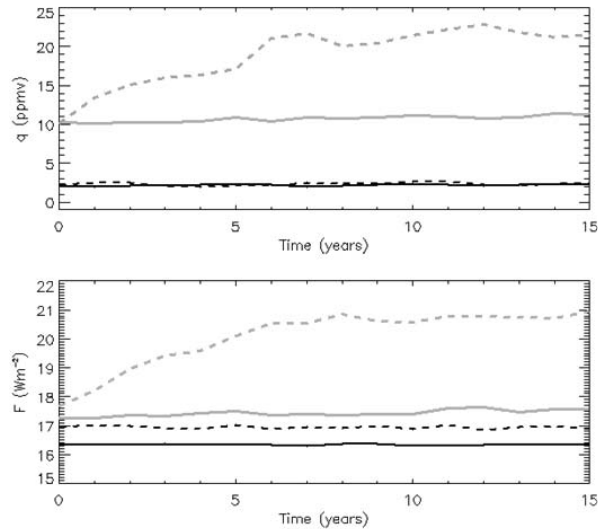
Fig. 6. Top panel: the evolution of globally averaged 60hPa spe- cific humidity in time in STD1 (solid black); STD2 (dashed black); LEP1 (solid grey) and LEP2 (dashed grey). Bottom panel: line colours and styles as for the top panel but for the evolution of down- ward LW radiation at the tropopause in Wm − 2